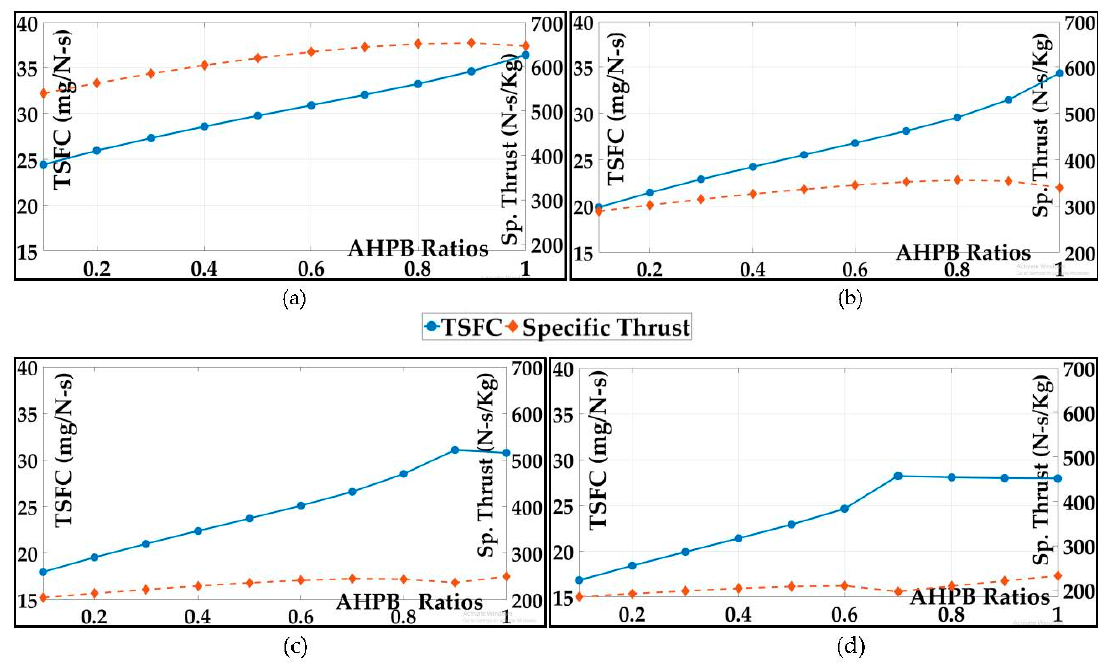
Figure 4. Plots of TSFC and specific thrust vs. AHPB ratios for ( a ) low-pressure bypass (LPB) = 2; ( b ) LPB = 6; ( c ) LPB = 10; ( d ) LPB = 12.